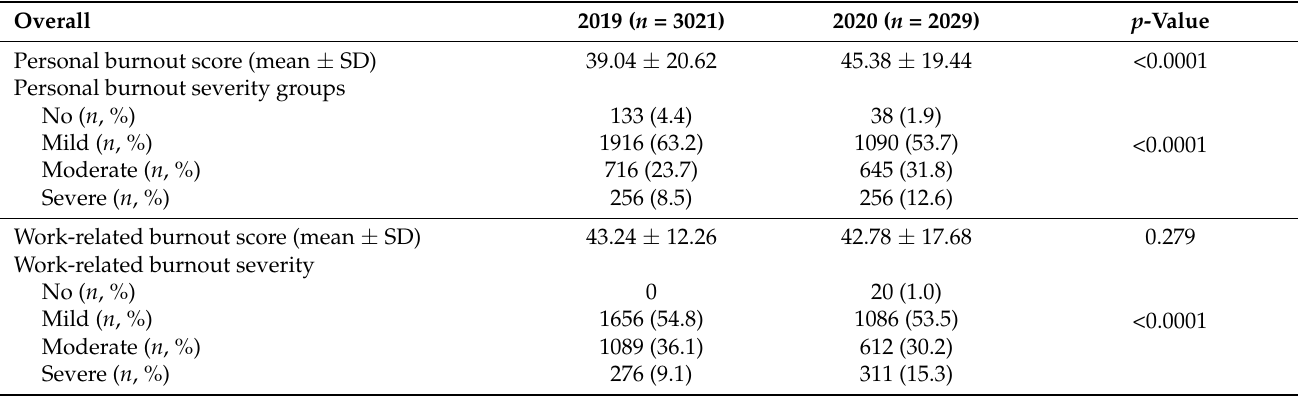
Table 4. Comparison of the personal and work-related burnout between 2019 and 2020 among (1) the overall population in 2019 and 2020 and (2) the participants with moderate/severe mood disorders in